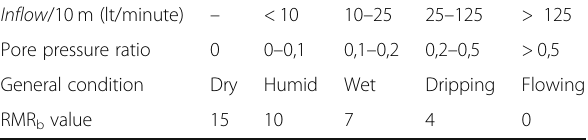
Table 5 The groundwater conditions classification (Bieniawski